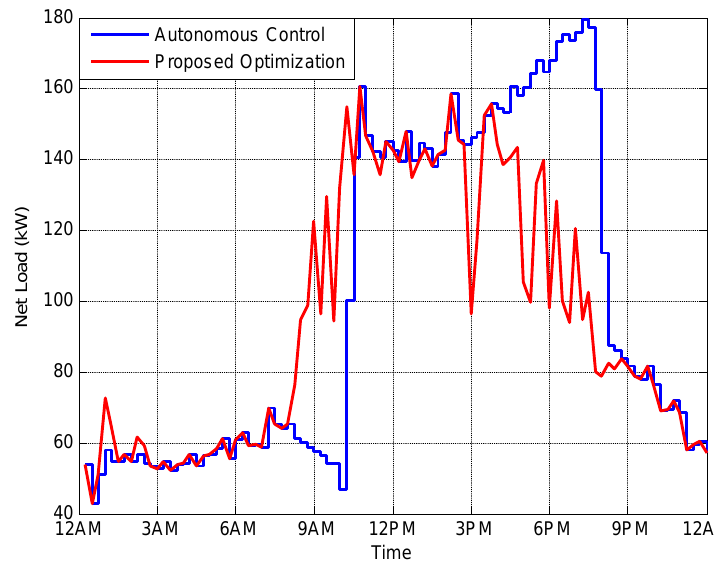
Figure 8. Load shifting in islanded